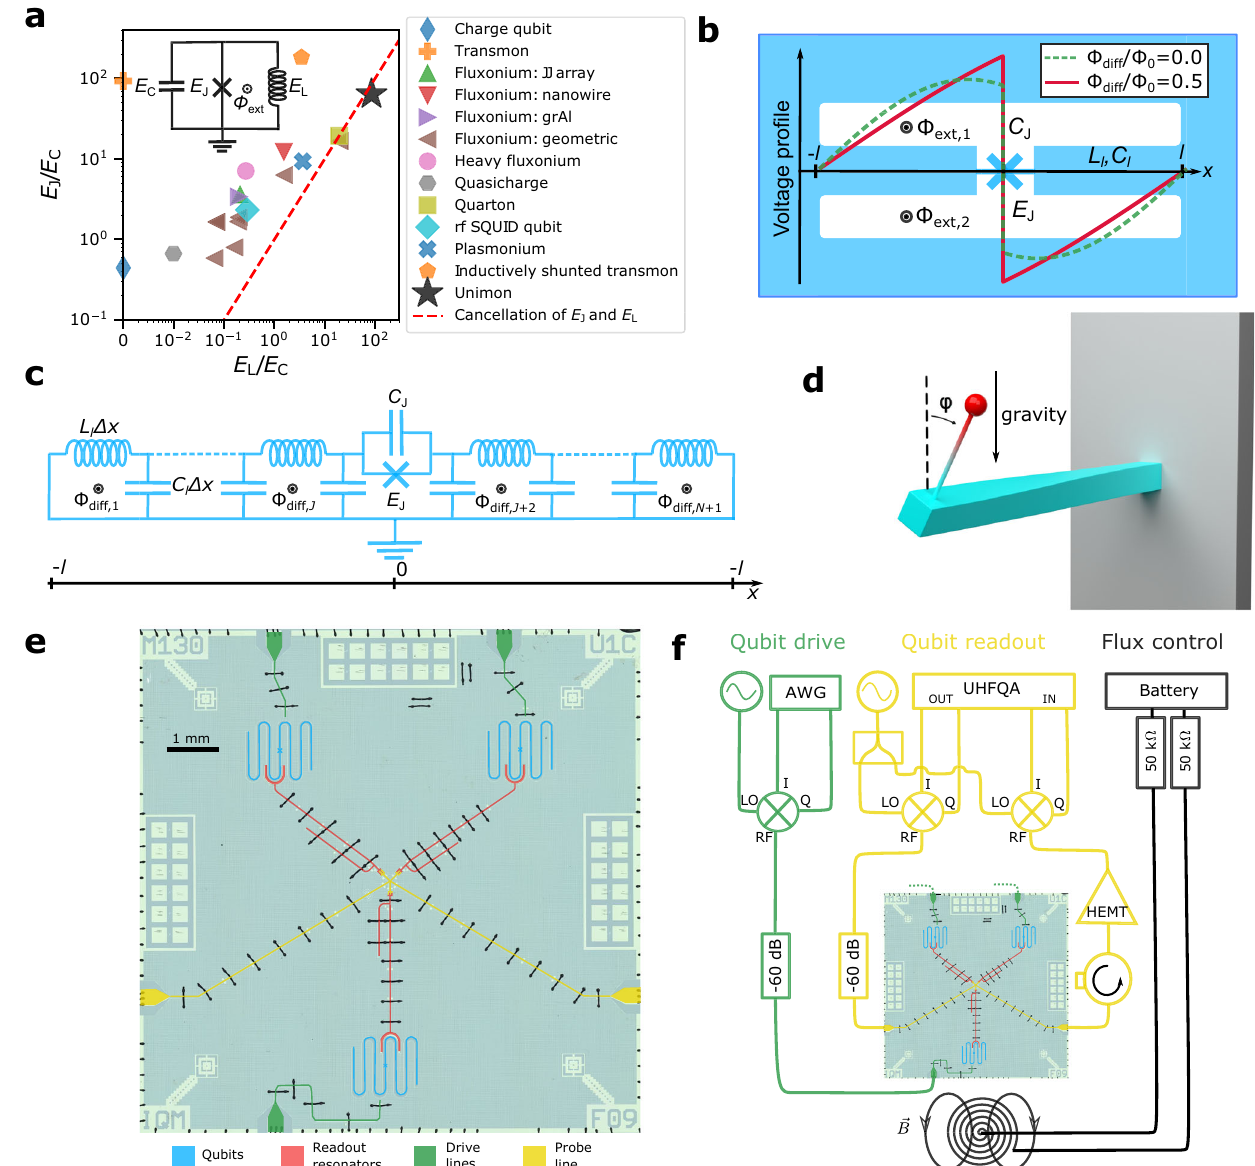
Fig. 1 | Unimon qubit and its measurement setup. a Superconducting-qubit types, described by the circuit in the inset, mapped by their energy scales: Josephsonenergy E J andinductiveenergy E L comparedwiththechargingenergy E C . Unimons lie near the red dashed line leading to the cancellation of the linear inductiveenergybythequadraticcontributionoftheJosephsonenergyathalf fl ux quantum Φ 0 /2. The black star denotes the unimons realized in this work and the other experimental data points are from refs. 32, 34, 37, 39, 42 – 44, 46 – 48, 80, 81. b SchematicunimoncircuitconsistingofaJosephsonjunction( E J , C J )inagrounded coplanar-waveguide (CPW) resonator of length 2 l and an inductance and capaci- tance per unit length of L l and C l , respectively. The voltage envelope functions of the qubit mode are also illustrated at external- fl ux biases Φ diff =( Φ ext,2 − Φ ext,1 )/ 2=0.0 (dashed line) and Φ diff = Φ 0 /2 (solid line). c Distributed-element the gravitationalpotential energy of the pendulum corresponds to the cosine-shaped Josephson potential, the harmonic potential energy associated with the twisting of the beam corresponds to the inductive energy of the unimon, and the moment of inertia of the pendulum is analogous to the capacitance in the unimon. Furthermore, the twist angle φ is analogous to the superconducting phase difference ^ φ m of the qubit mode acrossthe Josephson junction. This mechanical analog provides great intuition to the physics of the unimon.